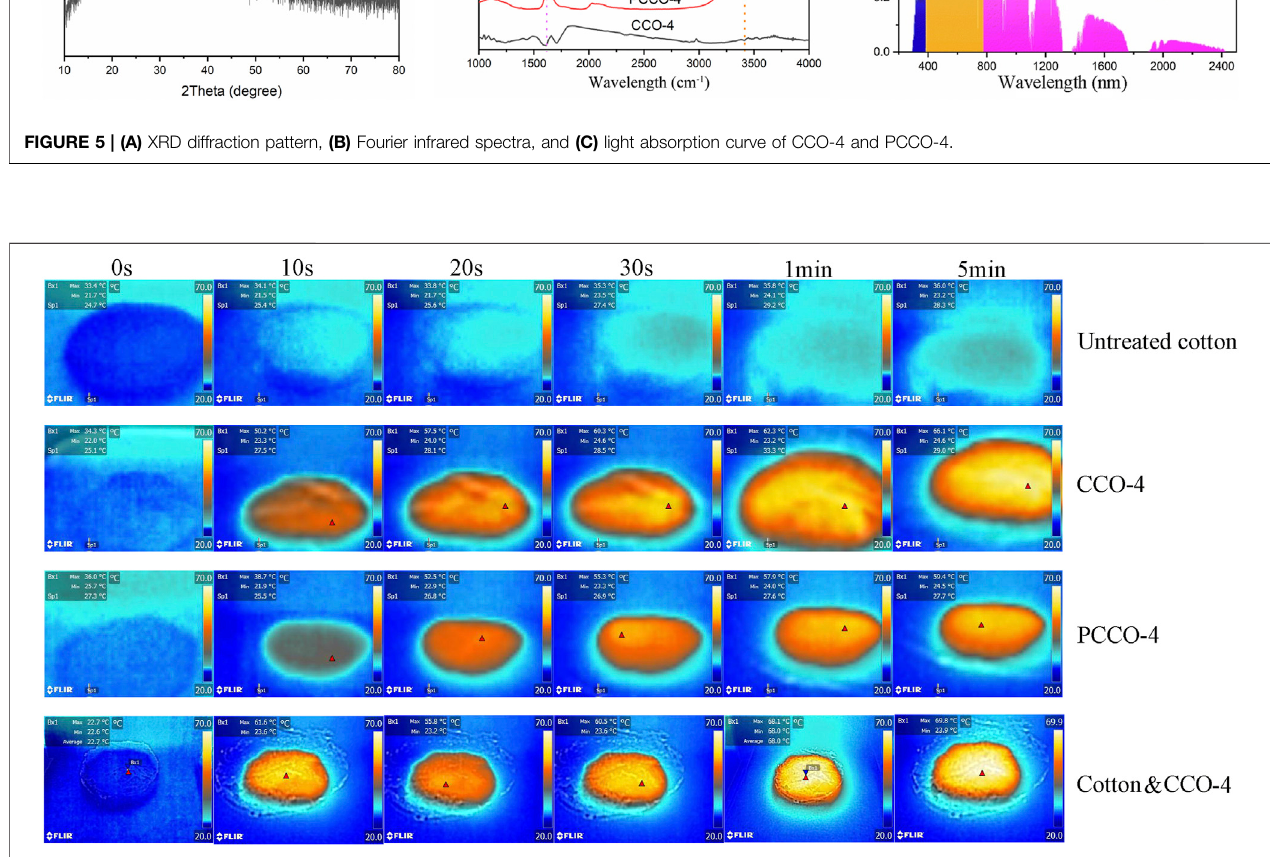
FIGURE 6 | Infrared thermal images of untreated cotton, CCO-4, PCCO-4, and Cotton & CCO-4 under 1 sun at 0 s, 10 s, 20 s, 30 s, 1 min, and 5 min.